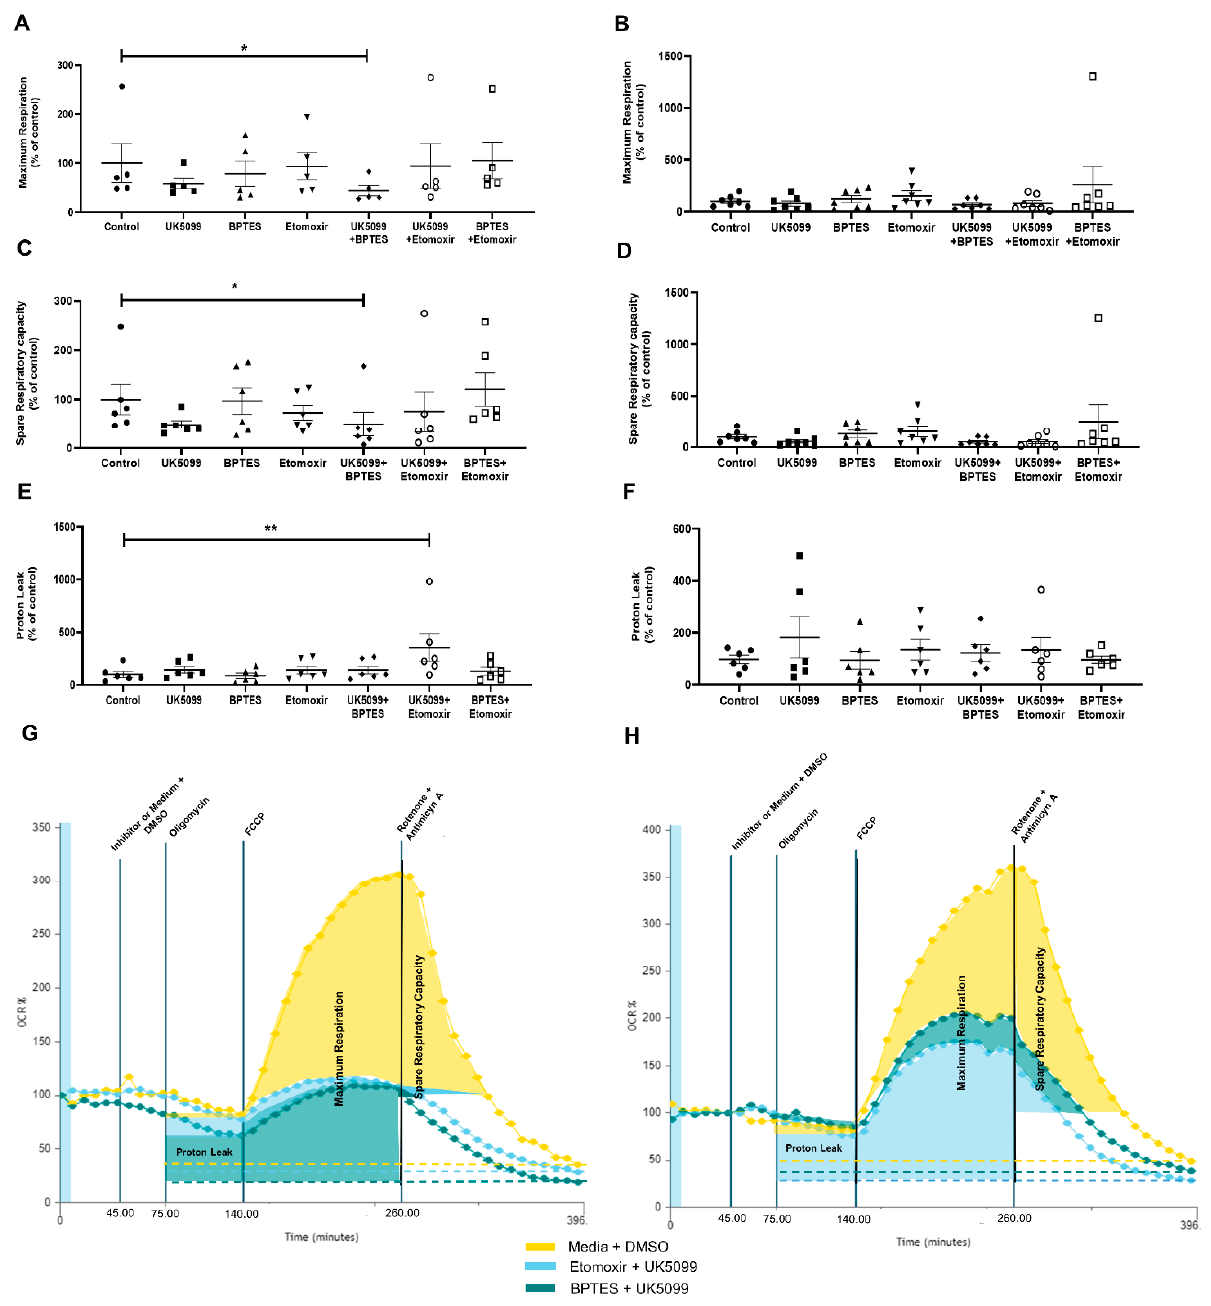
Figure 3. Influence of metabolic pathway inhibitors on maximum respiration, spare respiratory capacity and proton leak of VAT pertaining to patients with obesity class 2 ( A , C , E ) or class 3 ( B , D , F ) (Friedman Test: * p < 0.05, ** p < 0.01). Illustrative graphics of VAT OCR vs. Time from patients with obesity class 2 ( G ) or 3 ( H ) obtained by Wave Software (Agilent Technologies). Colored areas represent different metabolic parameters that were calculated.